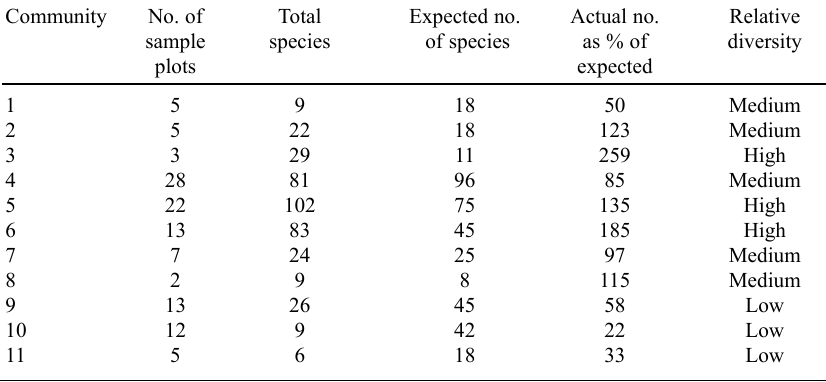
Relative species richness of plant communities in the PNB Community No. of Total Expected no. Actual no. sample species of